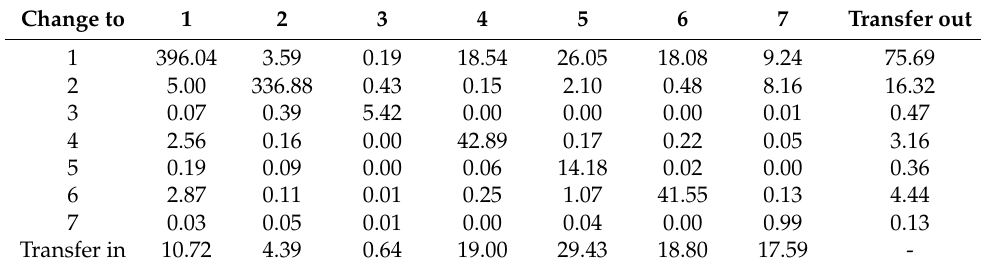
Table 5. Land use transfer matrix for 2000–2020 (km 2 ).